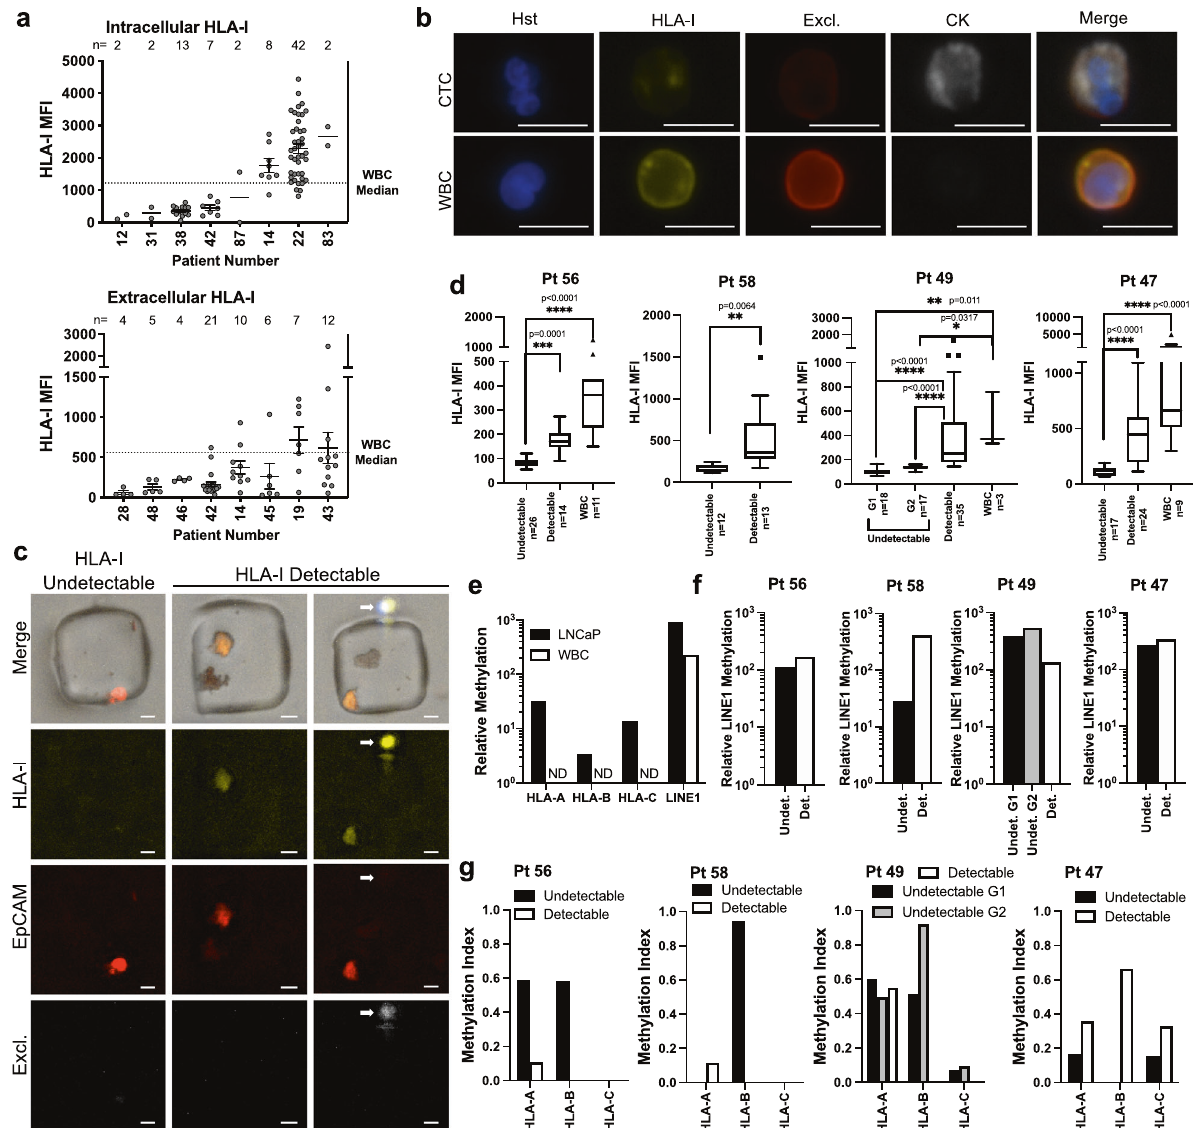
Fig. 7 HLA-I expression and methylation in circulating tumor cells. a Intra- and extracellular HLA-I protein expression in circulating tumor cells from two cohorts of 8 patients with prostate cancer. Dotted line represents median HLA-I expression in all patient matched white blood cells (WBCs). b Representative ×40 images of a CTC with low HLA-I expression and a WBC near the median expression from the total HLA-I group. Hoechst (Hst; blue; CD45/CD34/CD11b/CD27 (Excl; red); pan-cytokeratin (CK; white). Scale bars represent 10 µ M. c Representative 10x images of HLA-I (yellow) undetectable and HLA-I detectable CTCs and a WBC (white arrow) in the single-cell aspirator microwells (Pt. 56) HLA-I (yellow), EpCAM (red), Excl. (white). Scale bars represent 10 µ m. d Mean fl uorescent intensity (MFI) of HLA-I in each CTC population and matched WBCs (where available). Statistical analysis was done by one-way ANOVA with the Kruskal – Wallis test, and Welch ’ s t -test for Pt 58. Approximately 10 – 15 CTCs were chosen to be aspirated from each group. e HLA-I methylation in 10 WBCs and 10 LNCaP cells puri fi ed by single-cell aspiration. f Relative LINE1 methylation in groups of ~10 – 15 CTCs puri fi ed by single-cell aspiration. g HLA-I methylation in HLA-I detectable and undetectable groups of ~10 – 15 CTCs puri fi ed by single-cell aspiration represented with a Methylation Index relative to methylation in LNCaP